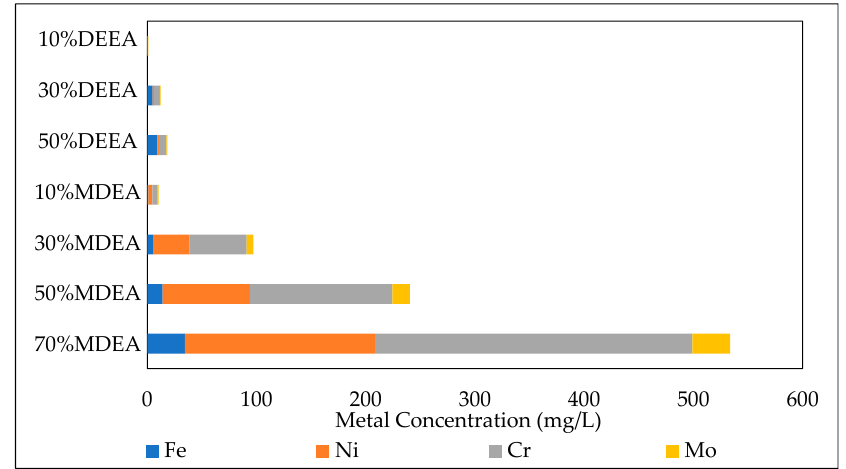
Figure 14. Metal concentrations of various aqueous MDEA and DEEA solutions after five weeks at CO 2 loading ≈ 0.4.